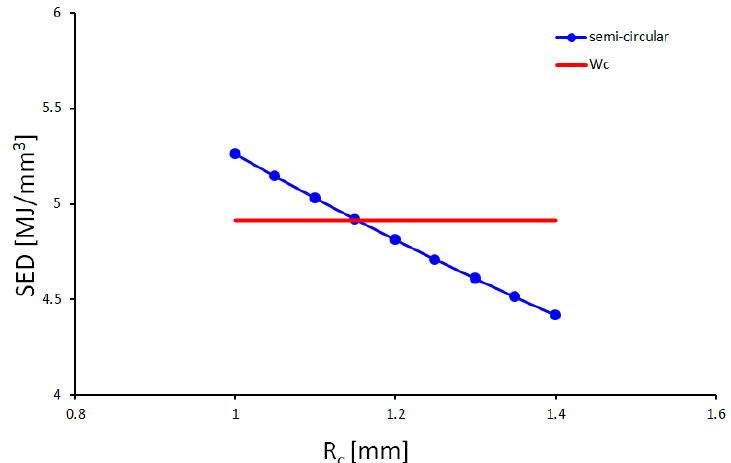
Figure 4. Determination of the critical radius value as the value at which a correspondence between the computed SED value (blue) and that obtained by means of Equation (1) (red) is found.